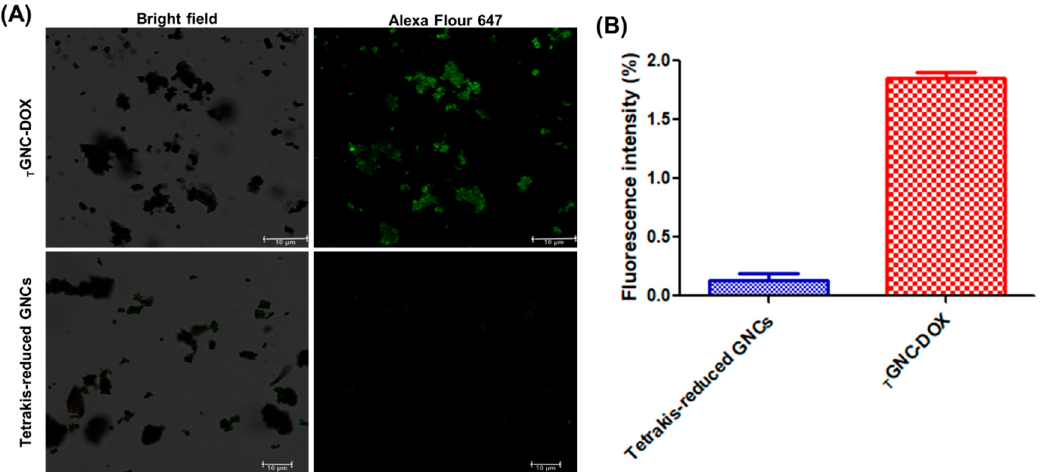
Figure 4. ( A ) The presence of HA in T GNC-DOX was confirmed by incubating T GNC-DOX and non-HA modified AuNPs i.e., Tetrakis-reduced gold nanoparticles with recombinant CD44 protein followed by anti-CD44 antibody treatment. Alexa fluor 647 was used as secondary antibody (green Fluorescence) (scale: 10 µ m). ( B ) Bar graph showing fluorescence intensity of T GNC-DOX and Tetrakis-reduced gold